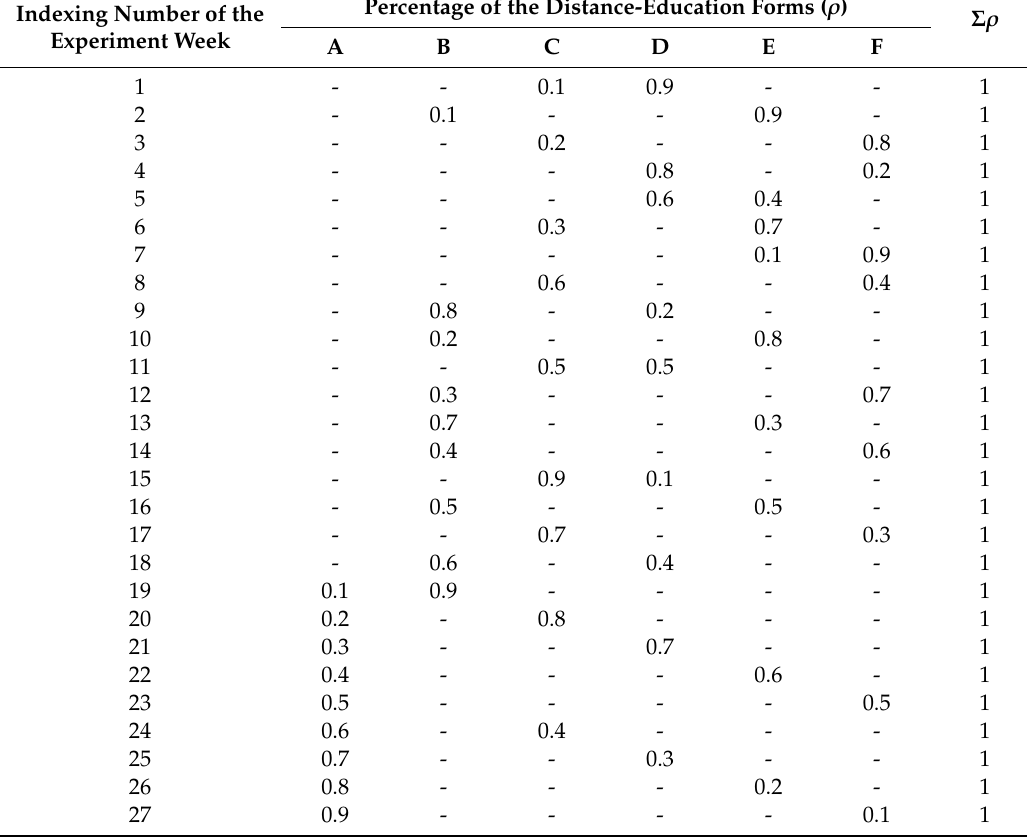
Table A2. Schedule for conducting an experiment to improve the distance-learning e ff ectiveness at the university: a case study of learning the discipline “Electric Machines in the Electrical Power-Generation